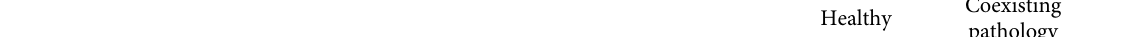
Table 3: Results of the Catquest questionnaire. For the seven difficulty items (questions 3 to 7), the question is: do you have difficulty with the following activities because of your vision? The points assigned for statistical analysis to the possible answers (except for question 2) are as follows: very great difficulties, 1; great difficulties, 2; some difficulties, 3; no difficulties, 4. For question 2, possible answers are very dissatisfied, 1; rather dissatisfied, 2; fairly satisfied, 3; very satisfied,